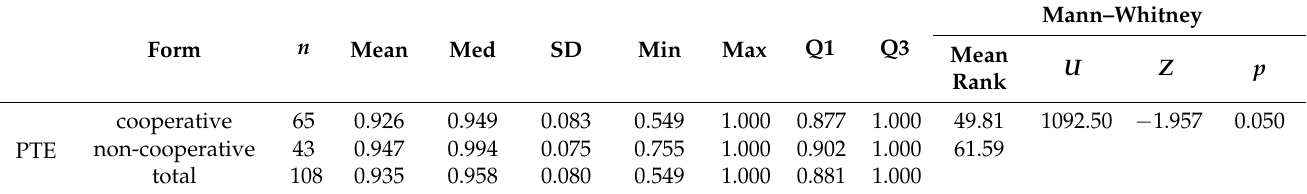
Table 5. Descriptive statistics of PTE scores and results of Mann–Whitney U test (authors’ calculations based on